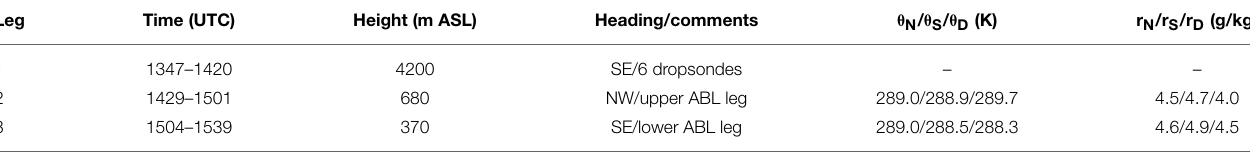
TABLE 1 | Seventh November 1999 flight legs.